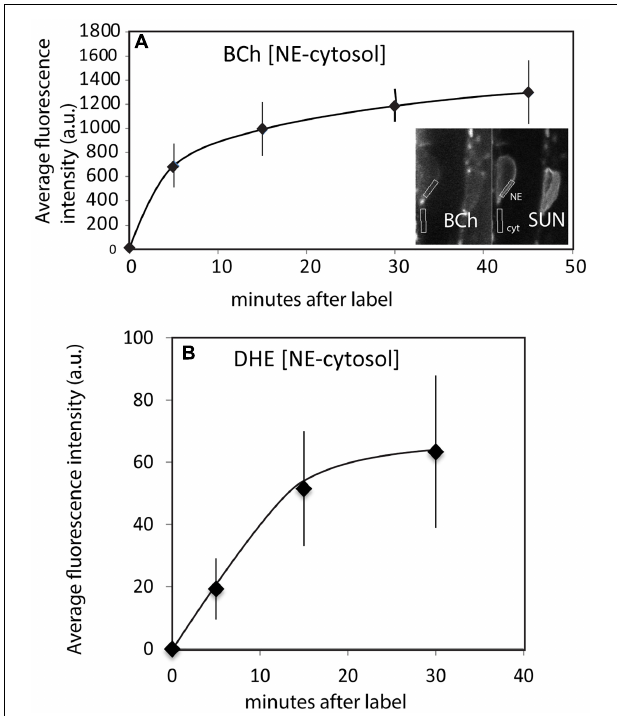
FIGURE 4 | Uptake of BCh and DHE into the NE over time. (A) Average fluorescence intensity of BCh taken over a region containing the NE with an equivalent area of the adjacent cytoplasmic fluorescence subtracted in plants expressing SUN-RFP. Error bars are the standard deviation of five separate samples. Inset shows the identification of the NE and adjacent cytoplasm in the SUN-RFP channel. (B) Average fluorescence intensity of DHE uptake into NE in plants expressing SINE2-GFP. The fluorescence background in the cytoplasmic region has been subtracted. Error bars are the standard deviation of five separate cells.